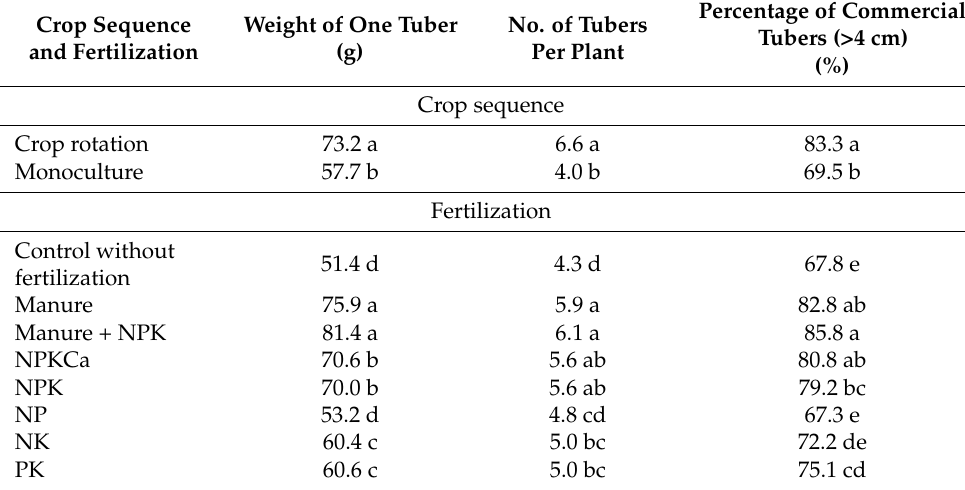
Table 4. Yield elements of potato tubers (mean of